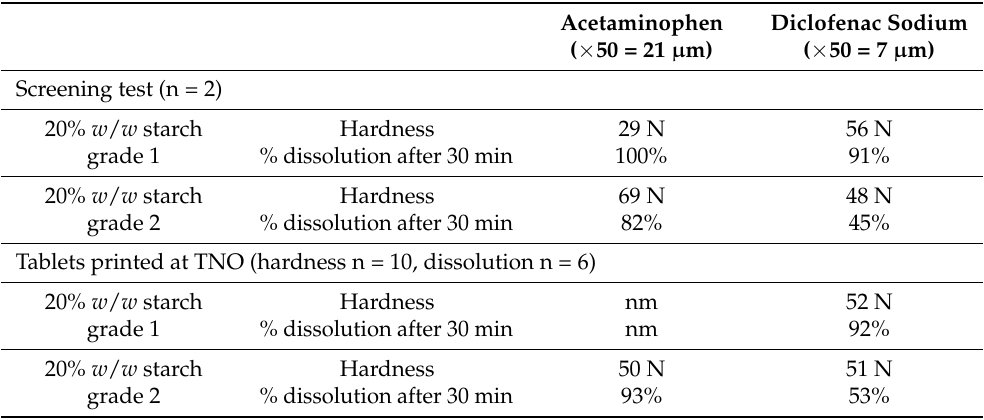
Table 2. Impact of different starch grades on tablet hardness and dissolution rate. Top (screening experiment): tablets were printed and analyzed via in-house screening method. Bottom: tablets printed at TNO with a line spacing of 0.35 mm and analyzed as provided in material and methods. nm = not measured. Dissolution rate is indicated as % w / w API released after 30 min dissolution